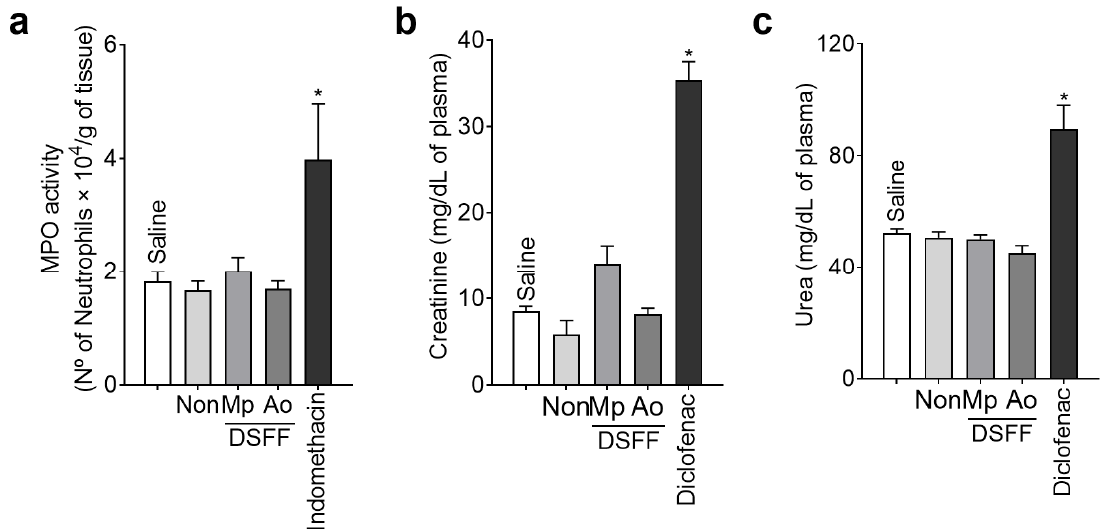
Figure 7. Evaluation of stomach and kidney toxicity markers. DSF-Non, DSFF-Mp, and DSFF-Ao (30 mg/kg) extracts do not induce increases in ( a ) MPO activity in the stomach or in ( b ) urea and ( c ) creatinine levels in plasma. Indomethacin (5 mg/kg) and diclofenac (200 mg/kg) were used as positive controls for stomach and kidney damage, respectively. Results are expressed as mean ± SEM of six mice per group per experiment and are representative of two independent experiments. * p < 0.05 vs. saline